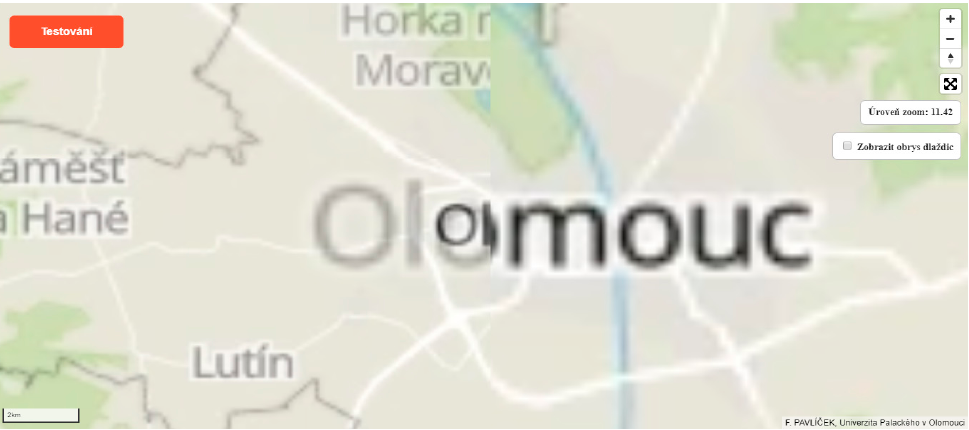
Figure 14. Visual appearance of raster tiles during fast zoom interaction.